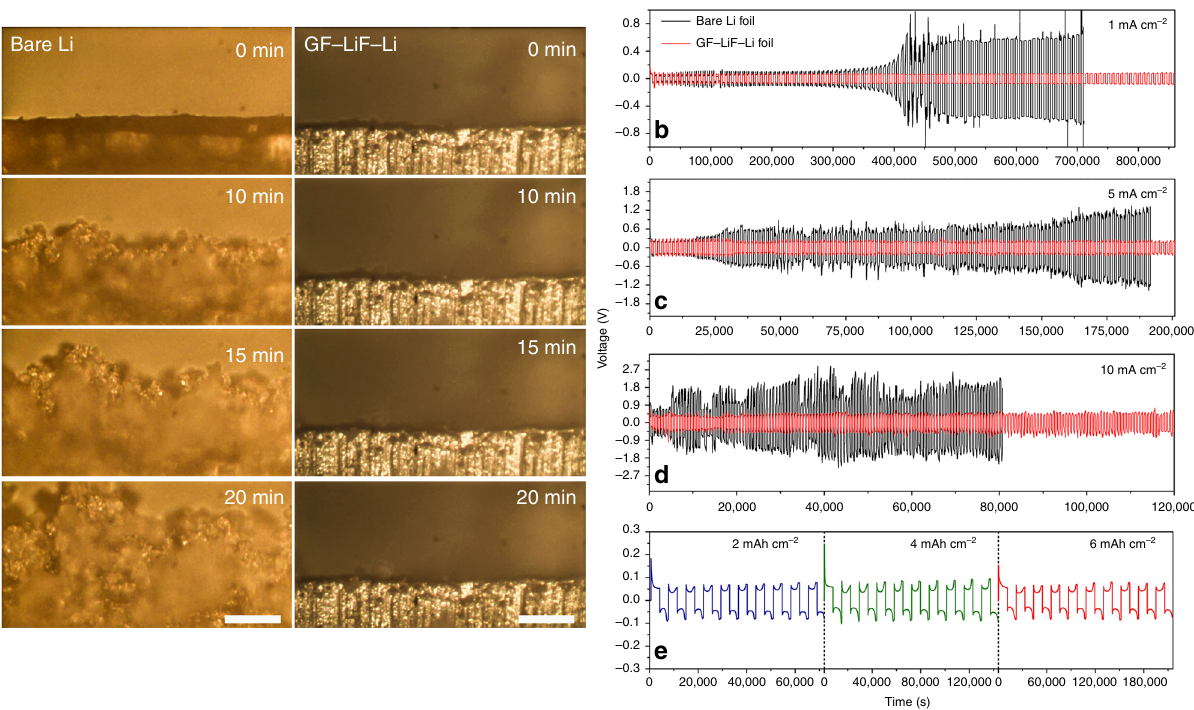
Fig. 3 In situ optical microscopy visualization of Li electrodeposition and long-term cycling on symmetric cells. a The images from microscopy of the bare Li (left column) and GF – LiF – Li (right column) electrolyte interface at 0, 10, 15, and 20min at a current rate of 3 mAcm – 2 . The scale bars are 200 μ m. Corresponding movies are provided in the Supplementary information. The Li deposition of bare Li (left) and GF – LiF – Li (right) in Li plating/stripping process. Bare Li foil symmetric cells (black) and GF – LiF – Li symmetric cells (red) at various current densities of ( b ) 1mAcm – 2 , ( c ) 5mAcm – 2 , and ( d ) 10mAcm – 2 . The capacity is 1 mAh cm – 2 . e Cycling performance of symmetric GF – LiF – Li cells cycled under 2mAcm − 2 with 2 – 6 mAh cm − 2